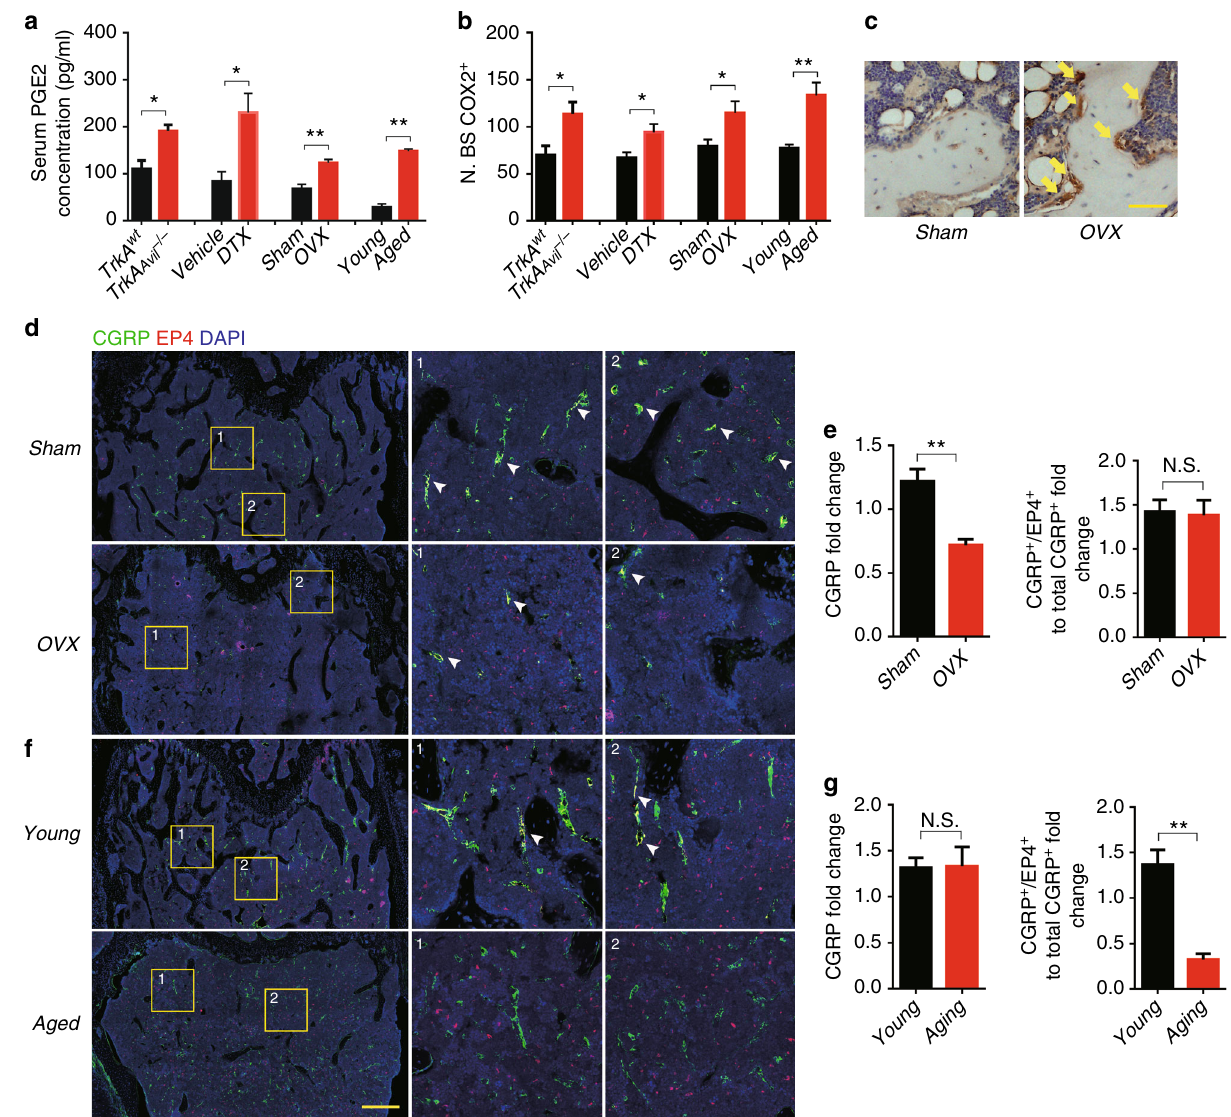
Fig. 3 Elevated PGE2 secretion from osteoblasts with sensory nerve dysfunction. a ELISA analysis of serum PGE2 levels in mice with different treatments, including TrkA wt and TrkA Avil − / − mice; iDTR Avil + / − mice injected with vehicle or DTX; young (2-month-old) and aged (12-month-old) mice; mice with sham or ovariectomy surgery (OVX) for 8 weeks. b Quantitative analysis of the COX2 + cells (brown) on trabecular surface of femoral bone from different mice models, including TrkA wt and TrkA Avil − / − mice; iDTR Avil + / − mice injected with vehicle or DTX; young (2-month-old) and aged (12-month-old) mice; and mice with sham or ovariectomy surgery (OVX) for 8 weeks. c Representative images of immunostaining of the COX2 + cells (brown) on trabecular surface of femoral bone from mice with sham or OVX for 8 weeks. Scale bar, 20 μ m. d , e Representative double-immuno fl uorescent staining imaged and quantitative analysis of EP4 (red) and CGRP (green) in femurs from mice underwent sham or OVX surgery. Scale bar: 100 μ m. f , g Representative double- immuno fl uorescent staining images and quantitative analysis of EP4 (red) and CGRP (green) in femurs from young and aged mice. Scale bar: 100 μ m. N ≥ 5 per group. * P < 0.05, ** P < 0.01 and N.S. means not signi fi cant. (Student t